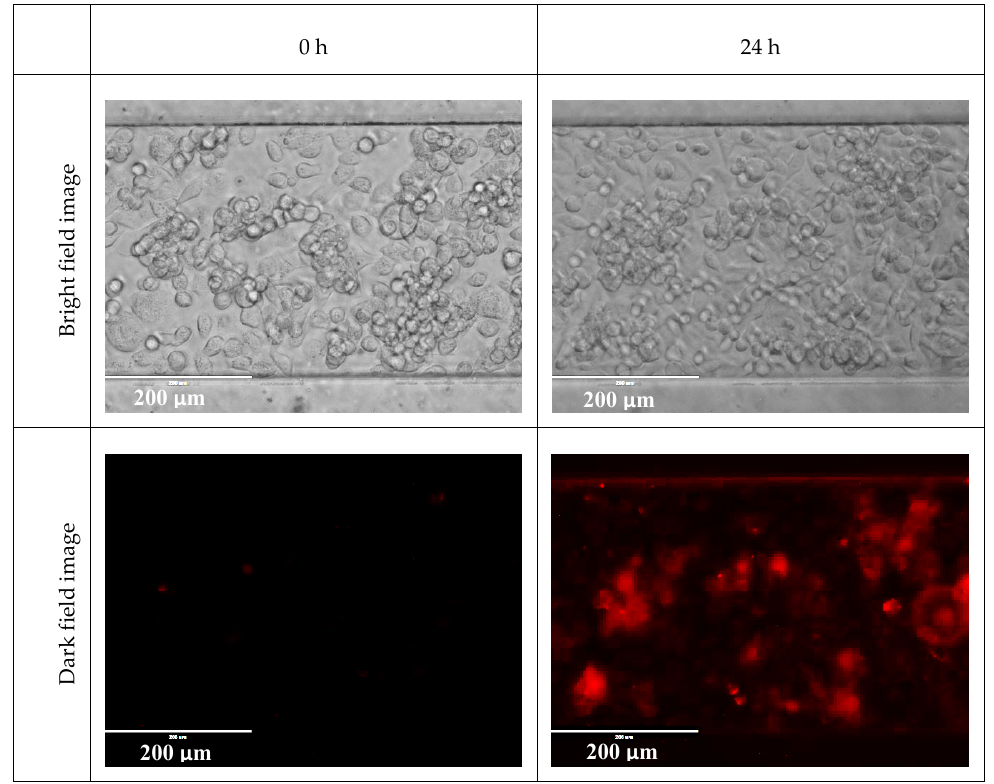
Figure A6. Bright field and dark field microscope images at 0 and 24 h of